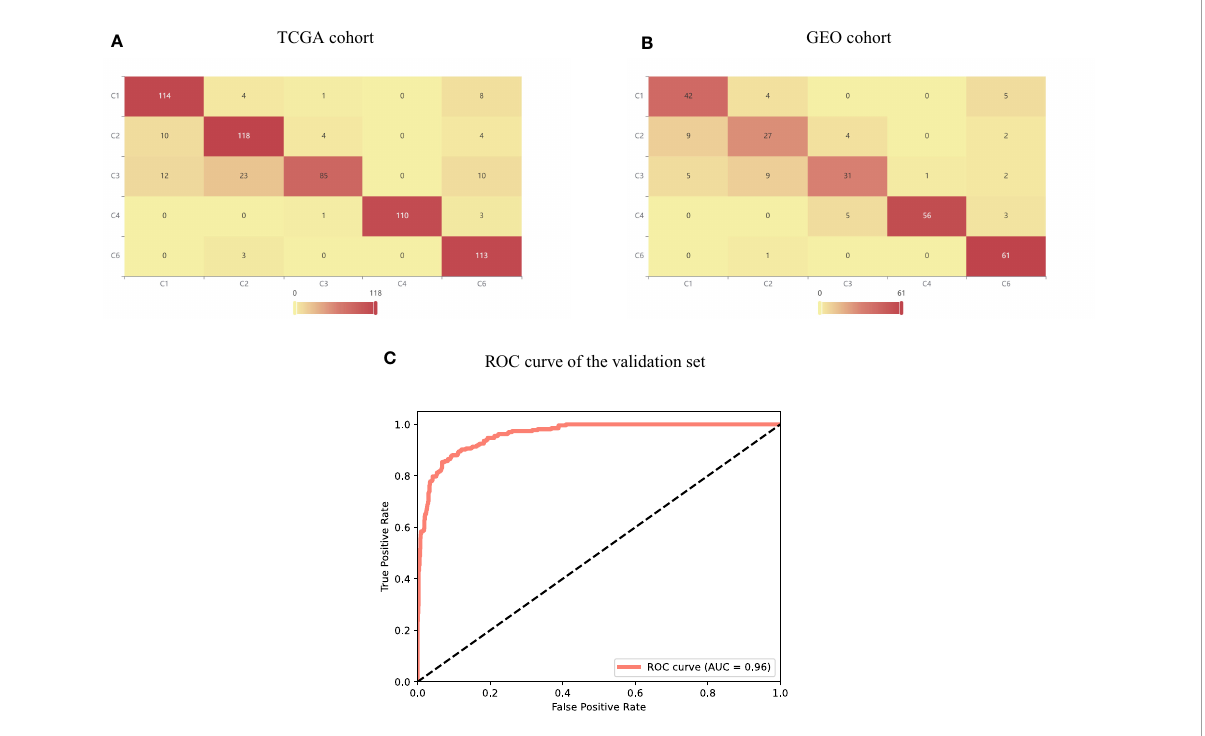
FIGURE 6 Performance of immune subtypes prediction based on transcriptional pattern. (A) Immune subtype prediction results of TCGA cohort. (B) Immune subtype prediction results of GEO cohort. (C) ROC curve of immune subtype prediction on GEO